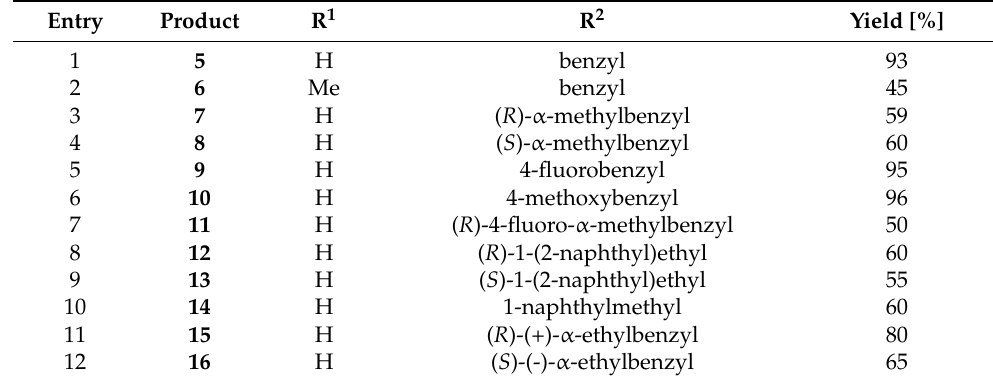
Table 1. Stereoselective syntheses of steviol-derived aminotriols.